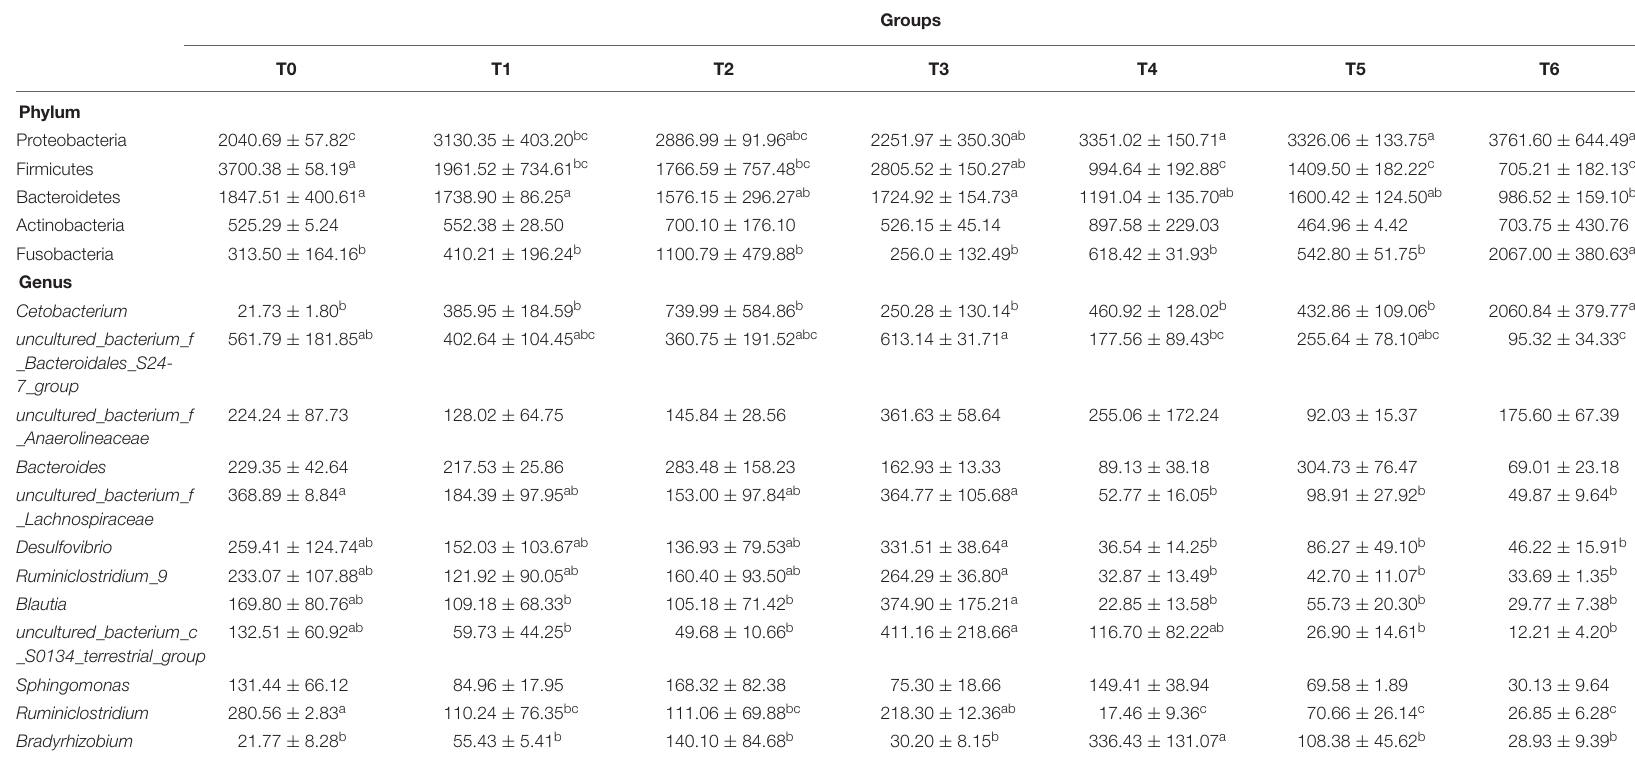
Different characters in the same row data indicate significant differences (P <